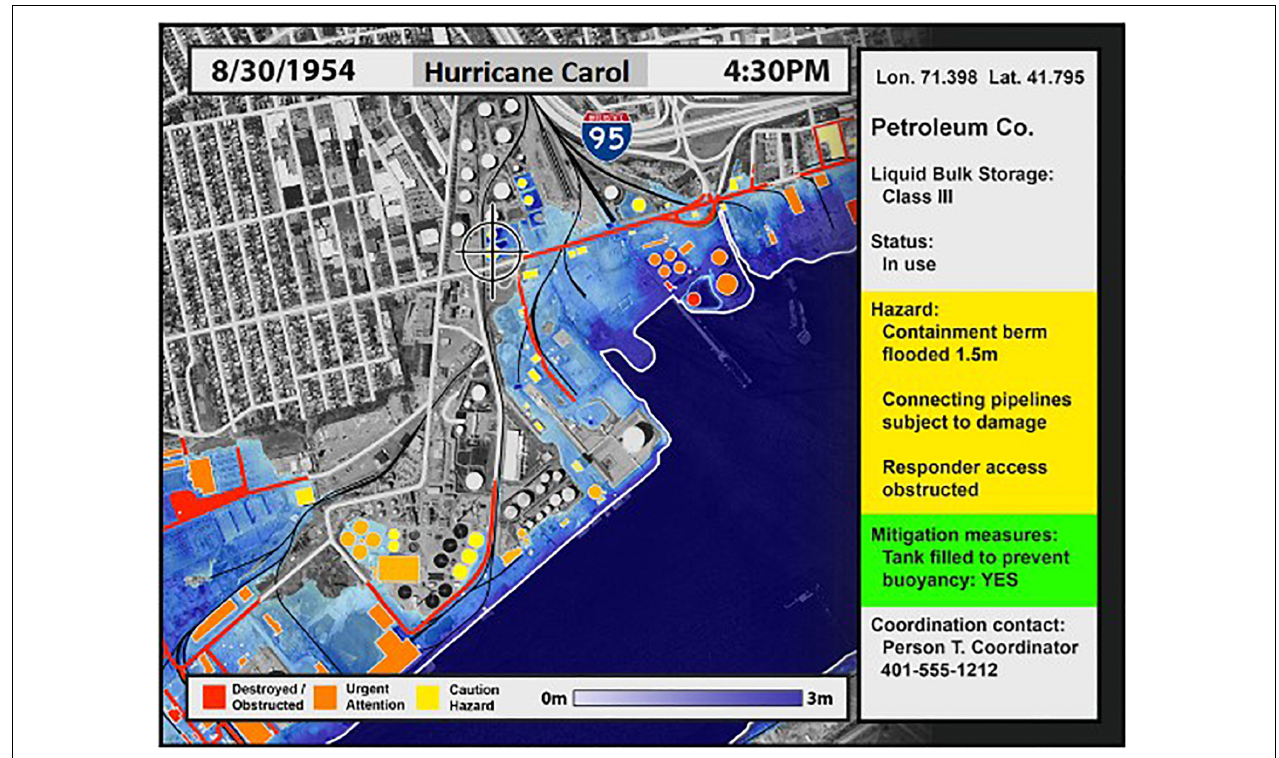
FIGURE 2 | Image used to explain potential of storm models during interviews (Image: authors, data from RIGIS).